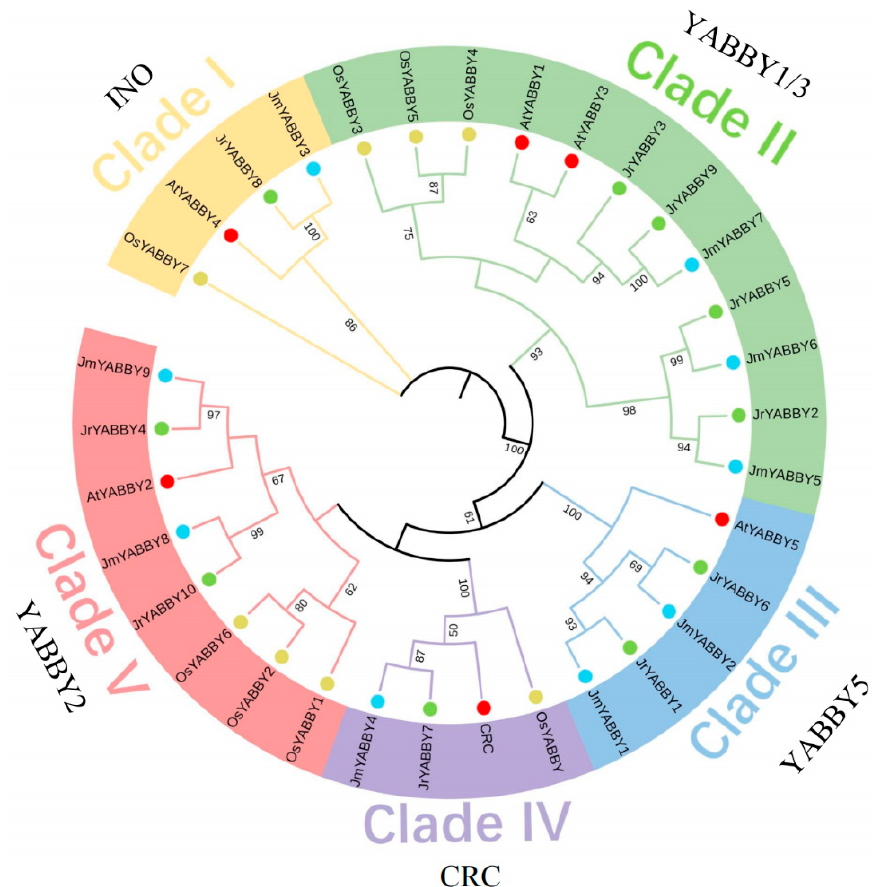
Figure 1. Maximum likelihood phylogenetic (ML) tree of YABBY proteins of Arabidopsis thaliana , Oryza sativa , Juglans regia , and Juglans mandshurica .